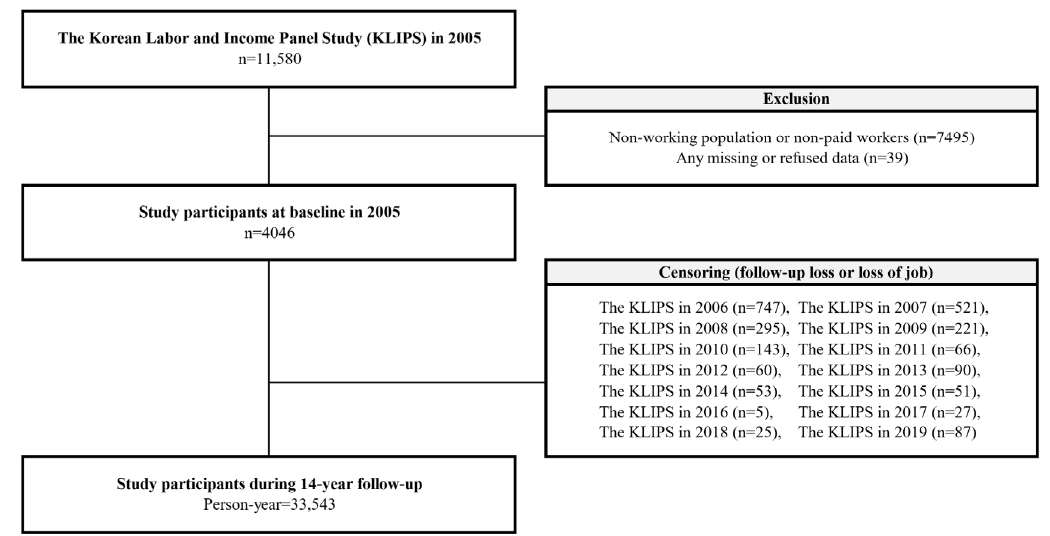
Figure 1. Schematic diagram depicting the study population.